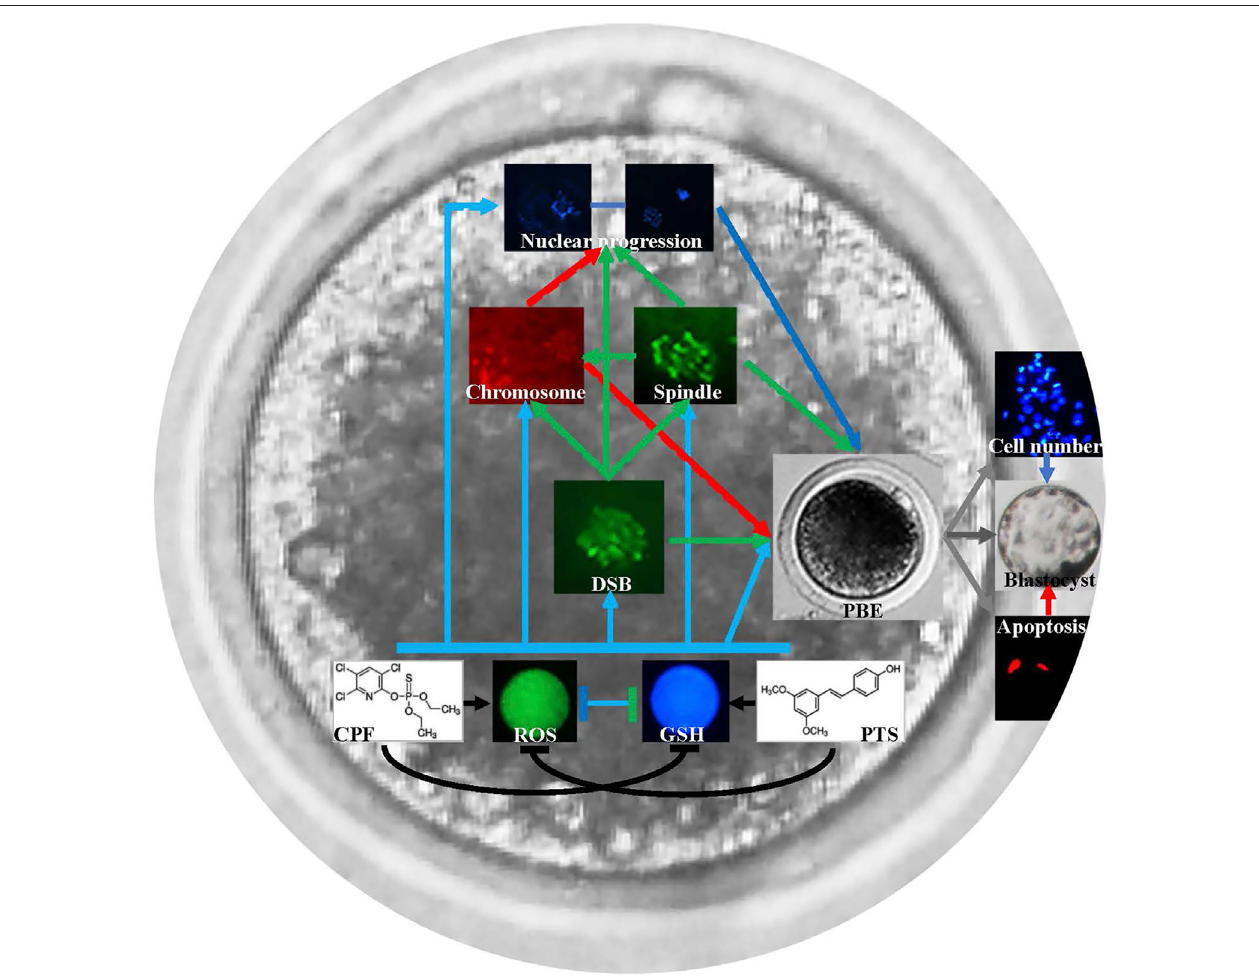
FIGURE 7 | Schematic representation of the protective role of PTS against CPF to ameliorate oocyte maturation. CPF breaks the redox balance to produce ROS andreduceGSH,causesDNAdamage,disruptsspindleassemblyandchromosomealignment,andfurtherdestroysoocytenuclearmaturationprogressionandoocyte maturation. PTS rescues CPF-mediated defects and ameliorates oocyte maturation.